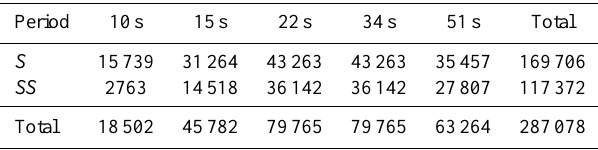
Table 1. Global data set of multiple-frequency shear-wave delay-